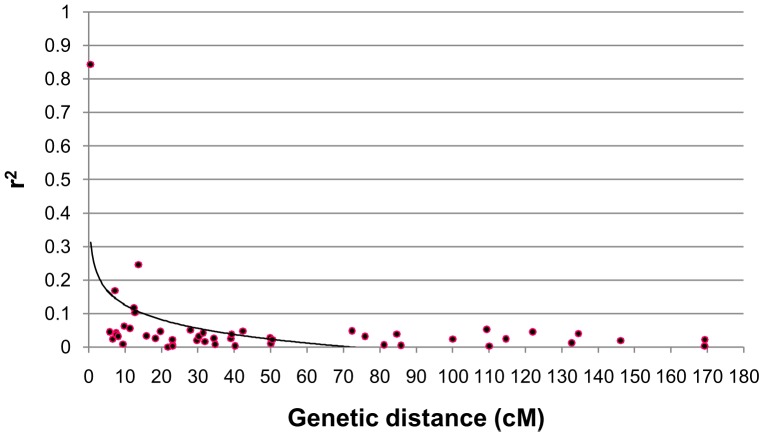
Scatter plots of r
2 values against genetic distance among linked loci (P≤0.01) in 356 G. hirsutum L. accessions.The trend line is a non-linear logarithmic regression curve of r
2 on genetic distance. LD decayed to the background (r
2 = 0.1182, P≤0.01), r
2 = 0.1 and r
2 = 0.2 level within about 12–13 cM, 17–18 cM and 3–4 cM, respectively.